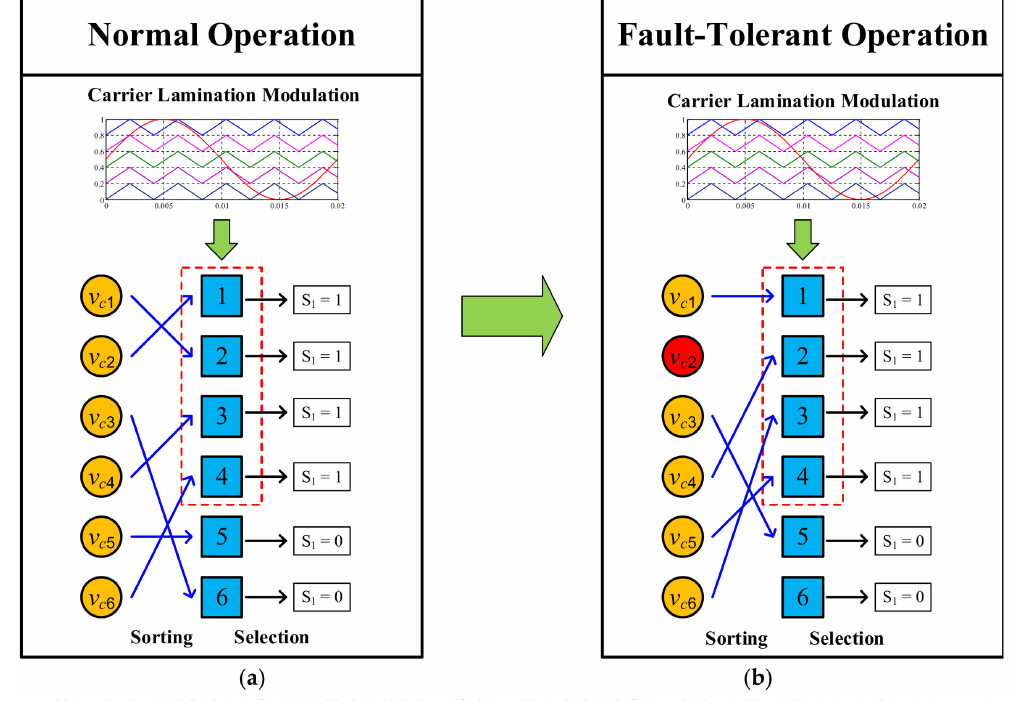
Figure 3. The improved sorting algorithm. ( a ) Normal operation; ( b ) Fault-tolerant